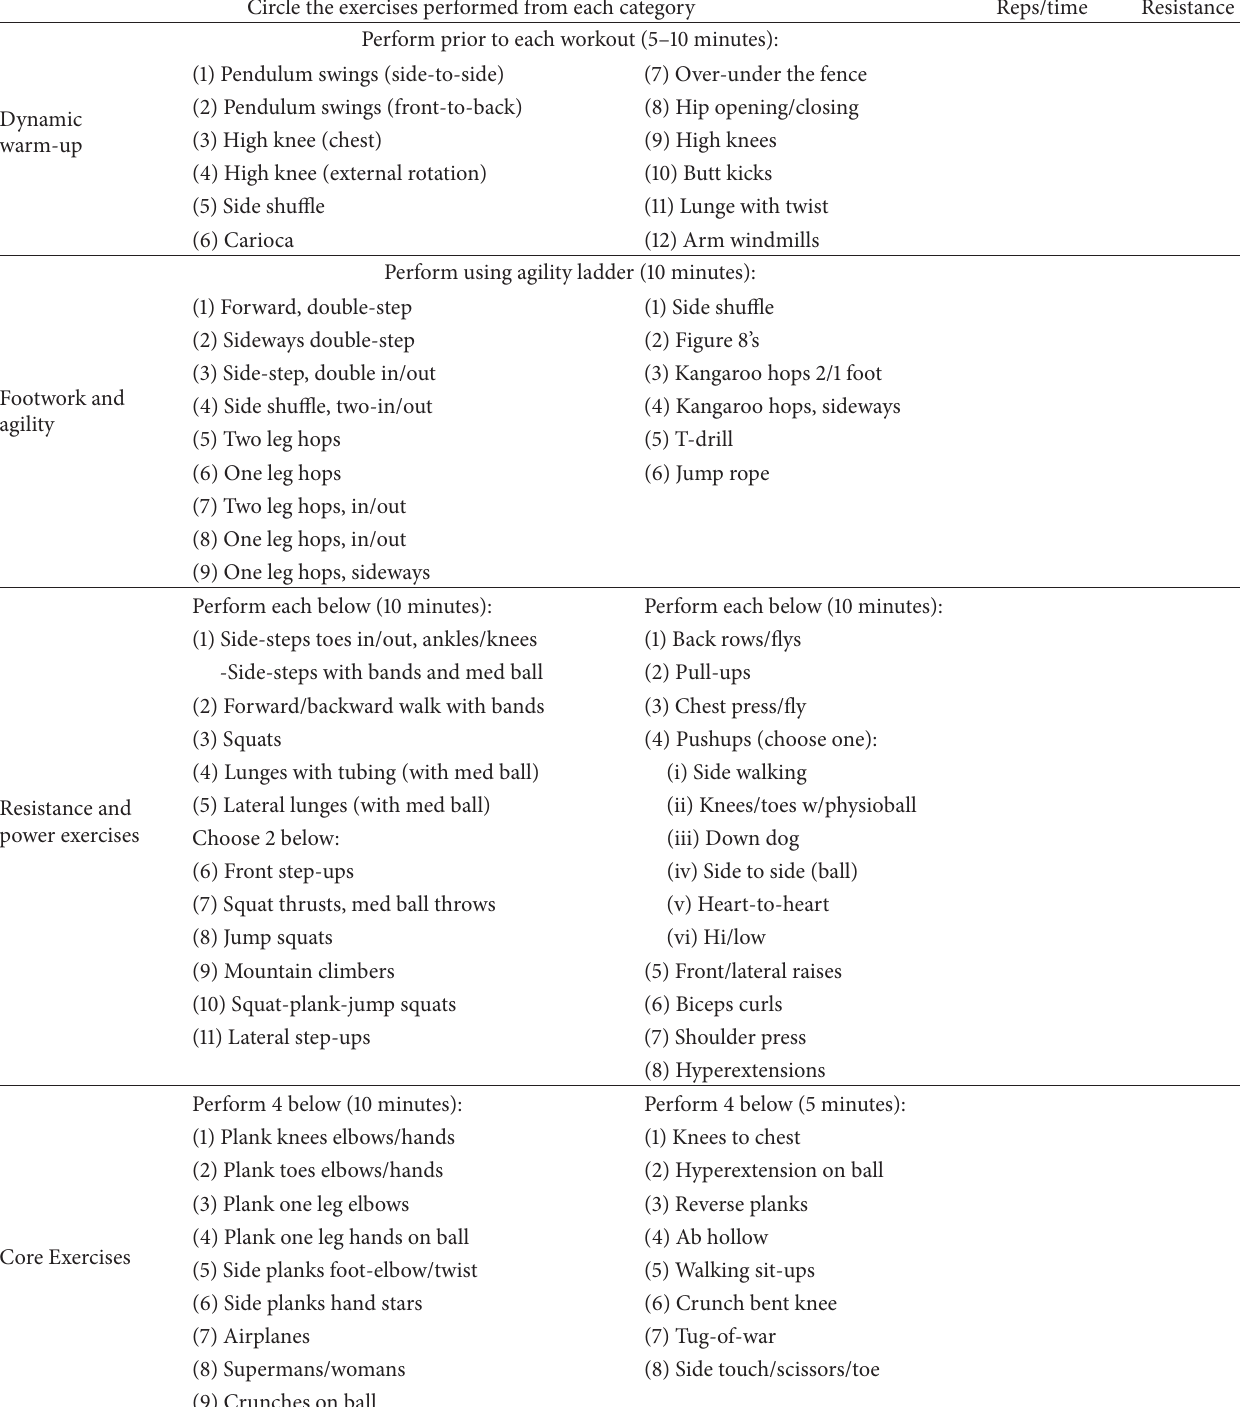
Table 2: Resistance exercise